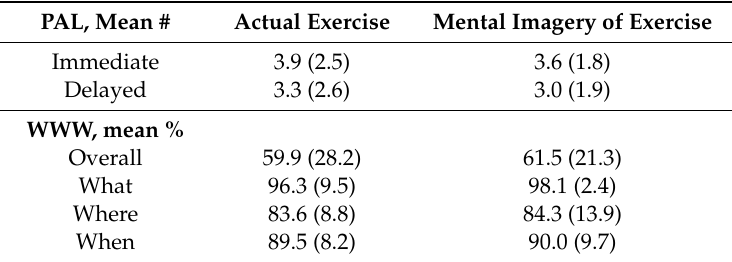
Table 3. Memory outcomes across the experimental